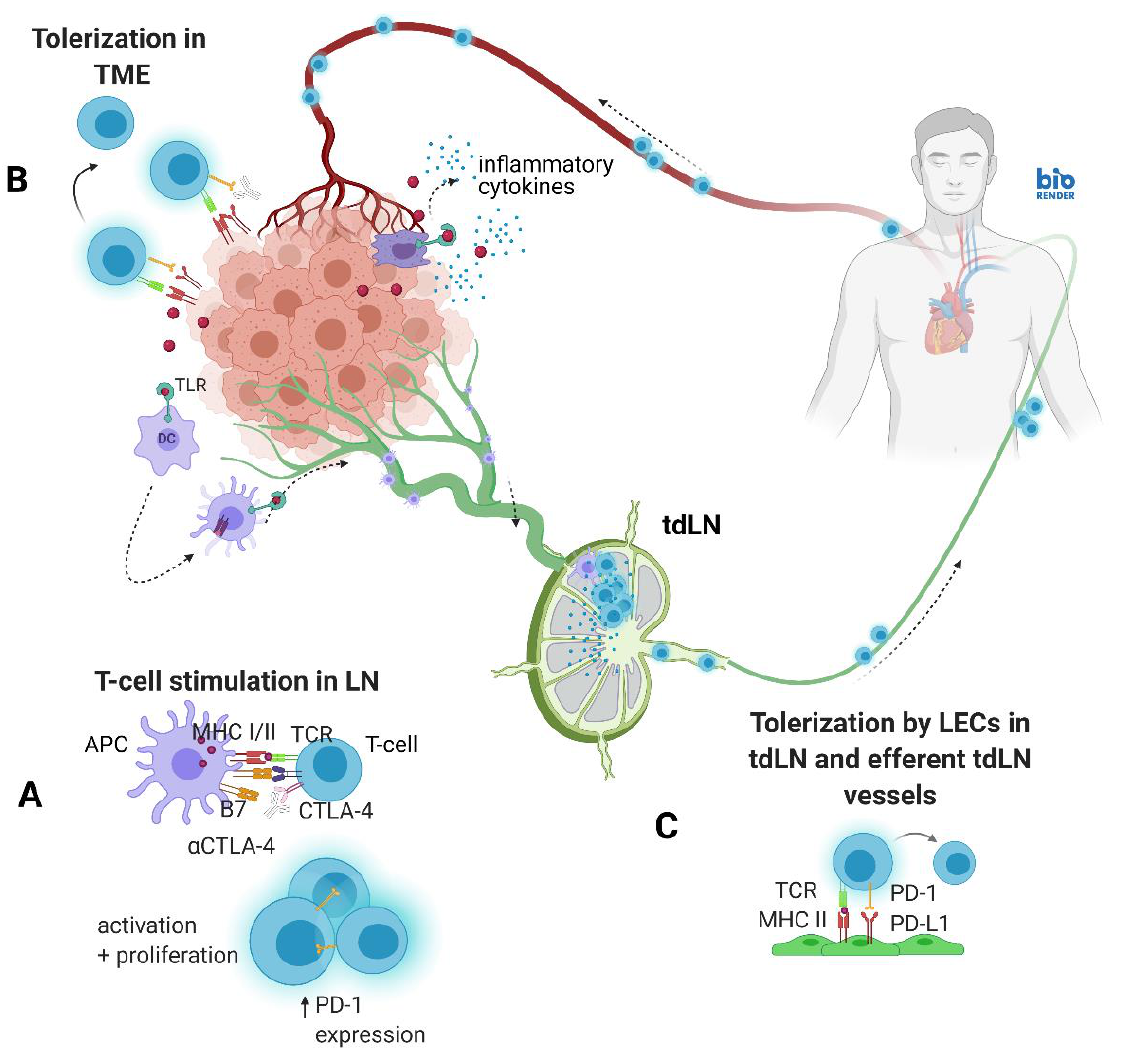
Figure 1. Lymph flow from tumor draining lymph nodes (tdLNs) to blood circulation. ( A ) Presen- tation of tumor antigen (tAg) by antigen presenting cells (APCs) to naïve T-cells in tdLNs initiates anti-tumor response. ( B ) Activated T-cells can be tolerized by PD-L1 expression within an immuno- suppressive tumor microenvironment (TME). ( C ) Lymphatic endothelial cells (LECs) may also present tAg and express high levels of PD-L1 to tolerize effector T-cells in tdLNs and efferent lymphatic vessels. TCR, T cell receptor; MHC, major histocompatibility complex; LN, lymph node. Created with Biorender.com (accessed on 21 February 2022).